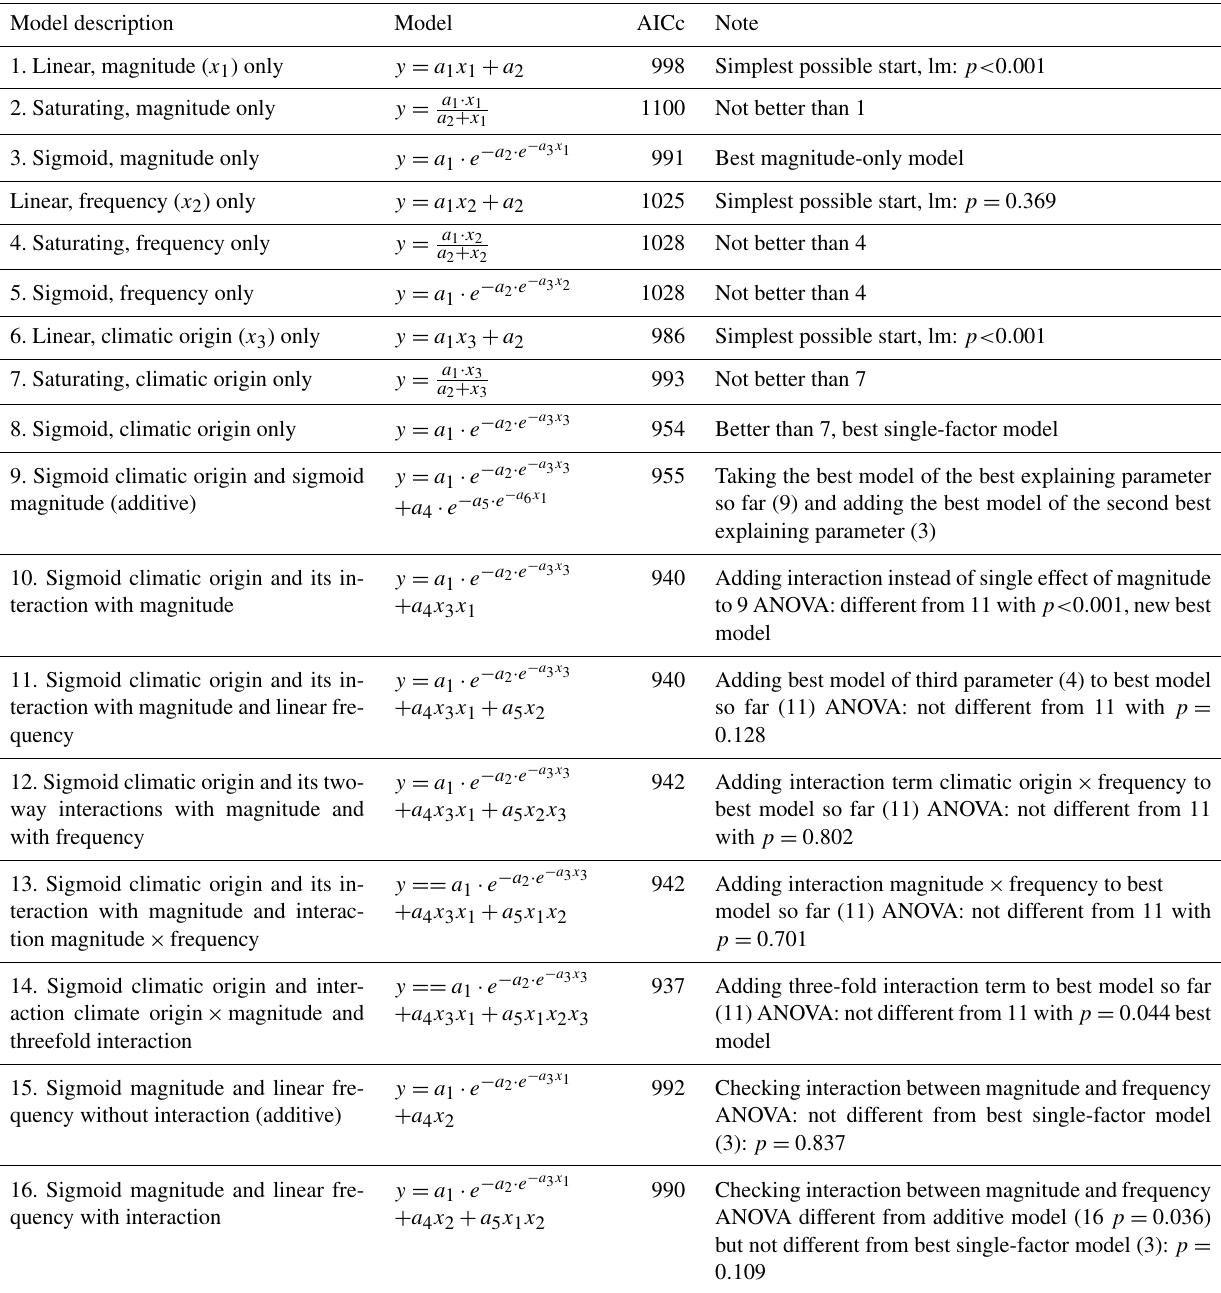
Table 5. Results of the hierarchical regression analysis for phosphate concentrations of beech forest soils with changes in FTC magnitude ( x 1 ), FTC frequency ( x 2 ), and climatic origin ( x 3 ; expressed as mean minimum winter temperature at origin) at the end of the FTC treatments. Tested are linear, saturating (Michaelis–Menten function), and sigmoid (Gompertz function) relationships on the single environmental drivers and their interactions. Bold AICc (Akaike information criterion corrected for small sample sizes) values indicate the best model. AICc in italics indicate the best single-factor models. a 1 to a n are the fitted parameters of the respective model. FTC: freeze–thaw